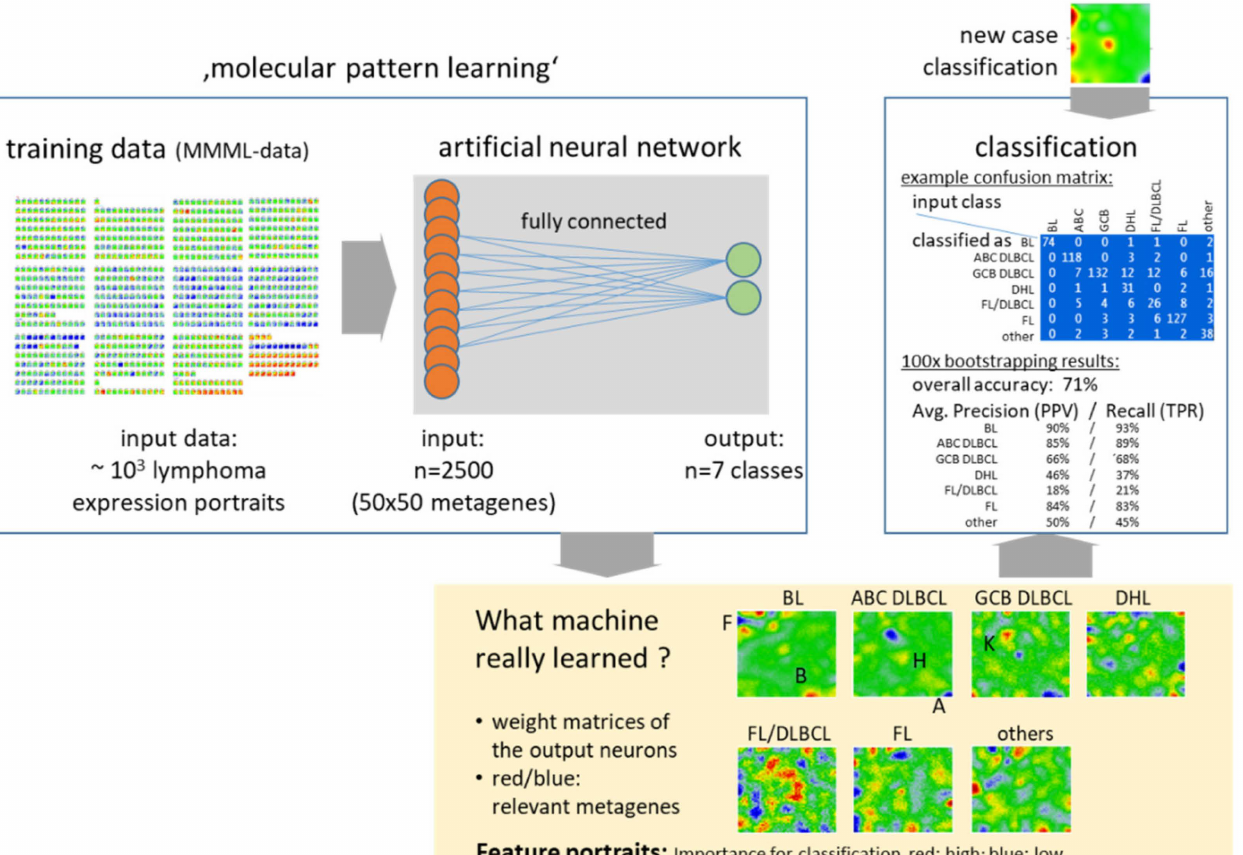
Figure A2. Machine learning of lymphoma subtype expression patterns: Based on expression portraits of the MMML data, the machine learned (fully connected, two-layered neural network) the expression patterns of seven subtypes in order to classify new cases. Relevant features for classification patterns are shown in the yellow box. It applied the layer-wise relevance propagation (LRP) method to visualize in SOM space what the machine really learned [84]. Classification quality was estimated as confusion matrix (input versus learned class), and precision (correct percentage of positive calls) and recall (percentage of actual true calls) values. Bootstrapping (10% randomly sampled for classification; 1000 iterations) was used for estimating the performance of